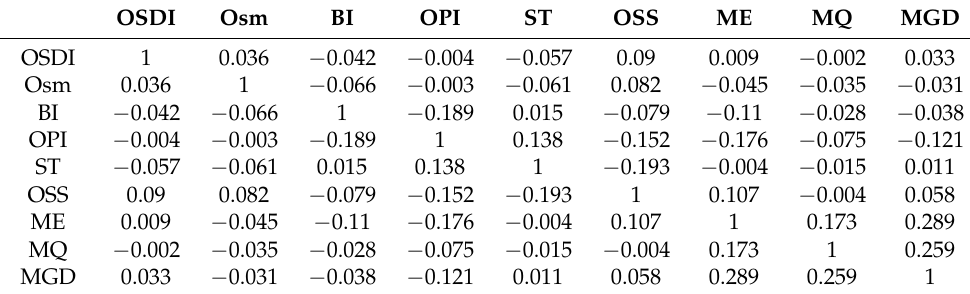
Table 7. Pearson’s correlation coefficient of determination ( r